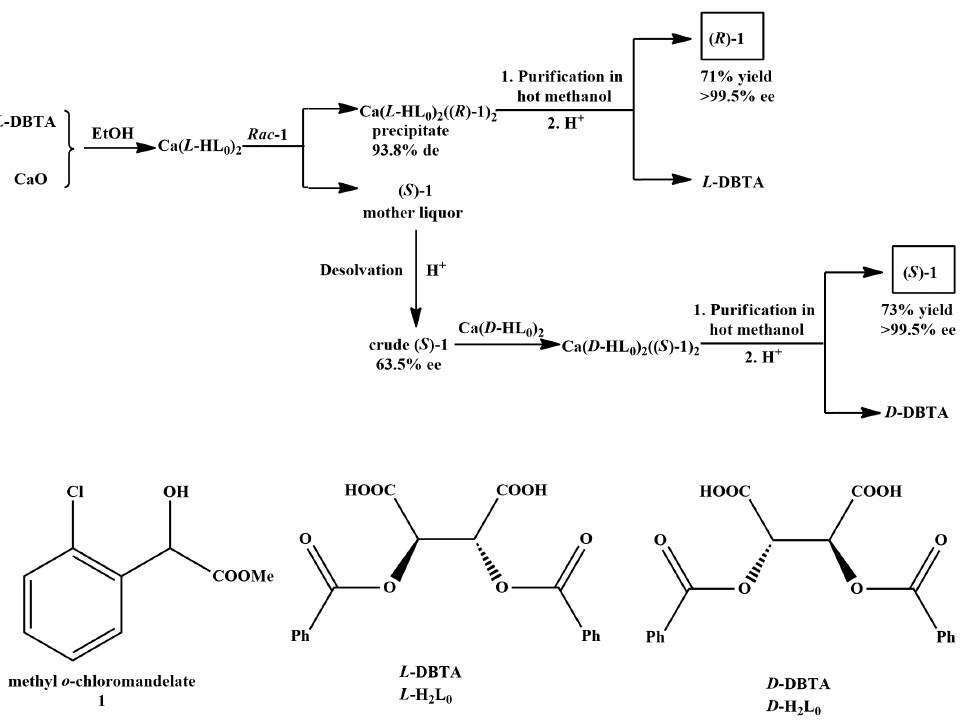
Figure 1: Coordination-mediated resolution of methyl o -chloromandelate with chiral O , O ′ -dibenzoyltartaric acid.